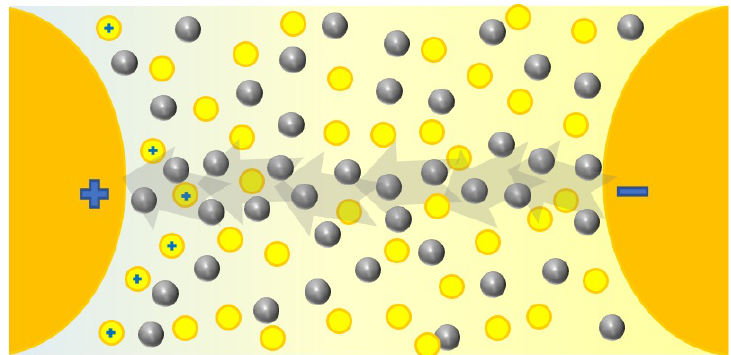
Figure 13. Conductive path of nanoparticles at high concentrations.